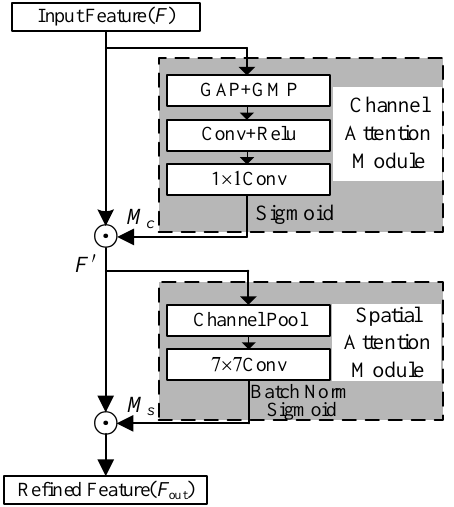
Figure 3. The architecture of CBAM [21] .